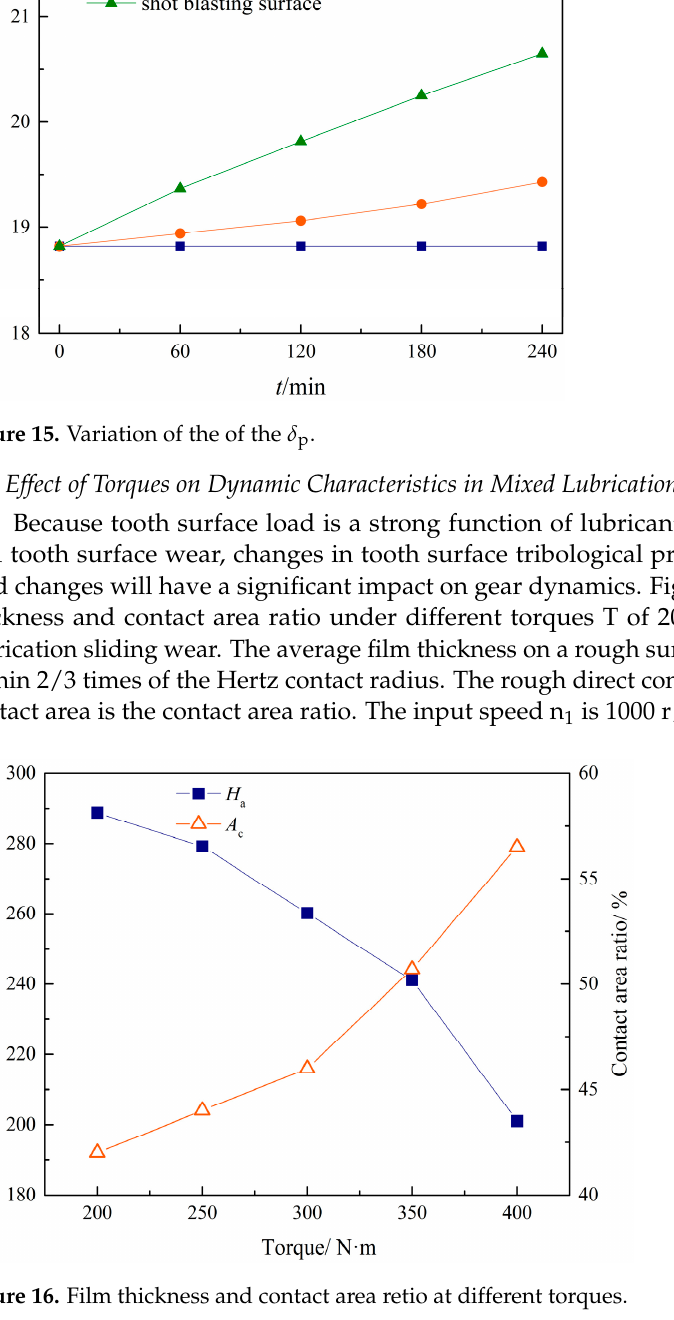
Figure 15. Variation of the of the δ p.